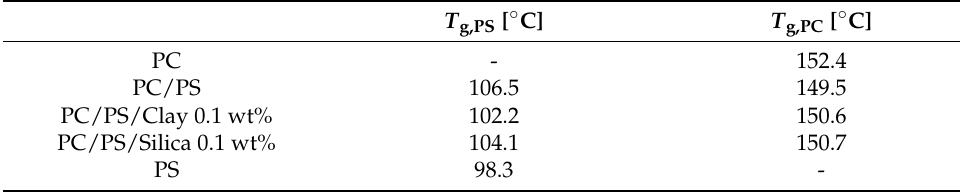
Table 3. Glass transition temperatures of PC ( T g,PC ) and PS ( T g,PS ).